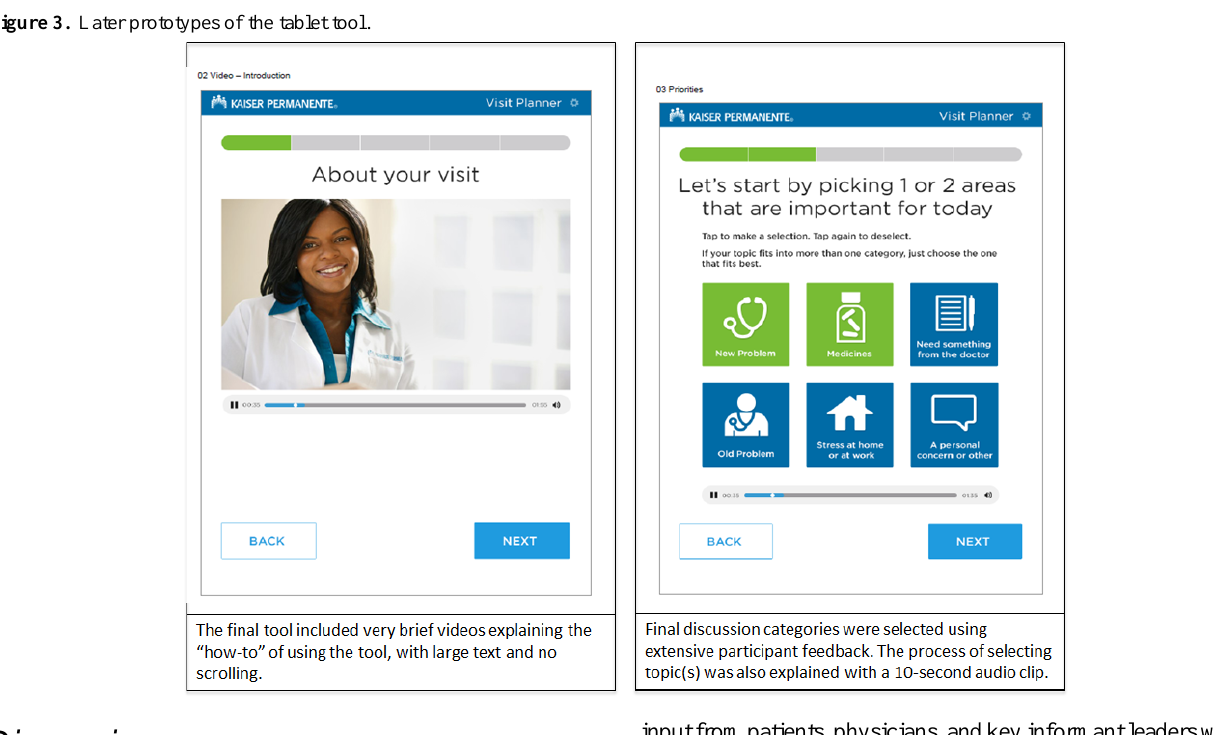
Figure 3. Later prototypes of the tablet